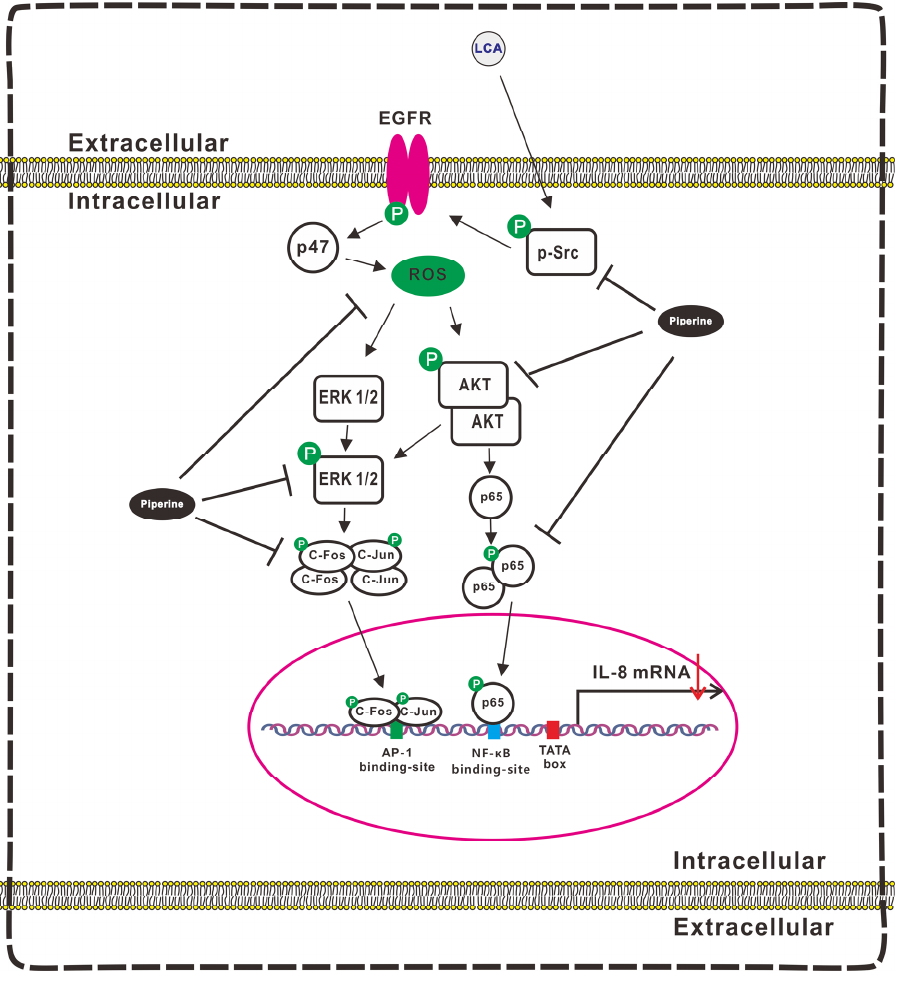
Figure 7. Schematic Representation of the Mechanism Underlying the Inhibitory Role of Piperine on LCA-Induced IL-8 Expression in CRC Cells and the Effect of CRC-Derived Angiogenesis in the Microenvironment. LCA induced IL-8 expression in human colorectal HCT-116 cells by increasing the transcriptional activity of AP-1 and NF- κ B through the Src/EGFR-mediated ROS signaling pathways in HCT-116 cells. Piperine suppressed LCA-stimulated IL-8 expression by inhibiting the transcriptional activity of AP-1 and NF- κ B and attenuating the Src/EGFR-mediated ROS-driven ERK1/2 and AKT signaling pathways. The CRC-derived IL-8 affects the endothelial EA. hy926 cell angiogenic activity in the microenvironment.